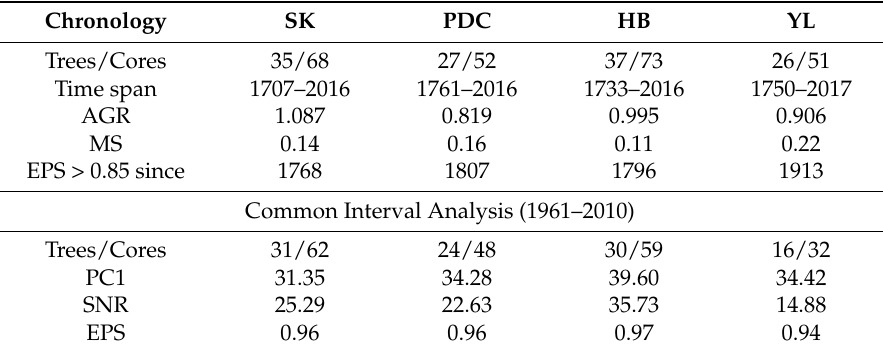
Table 2. Statistics of tree ring width residual